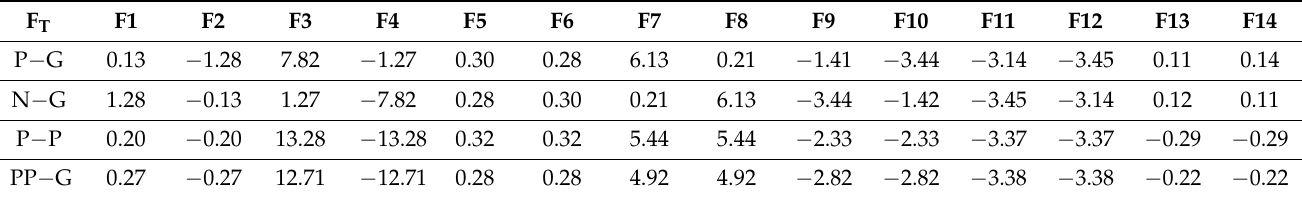
Table 4. Features at R1 for a fault at 50% of Line-1 with R f = 1